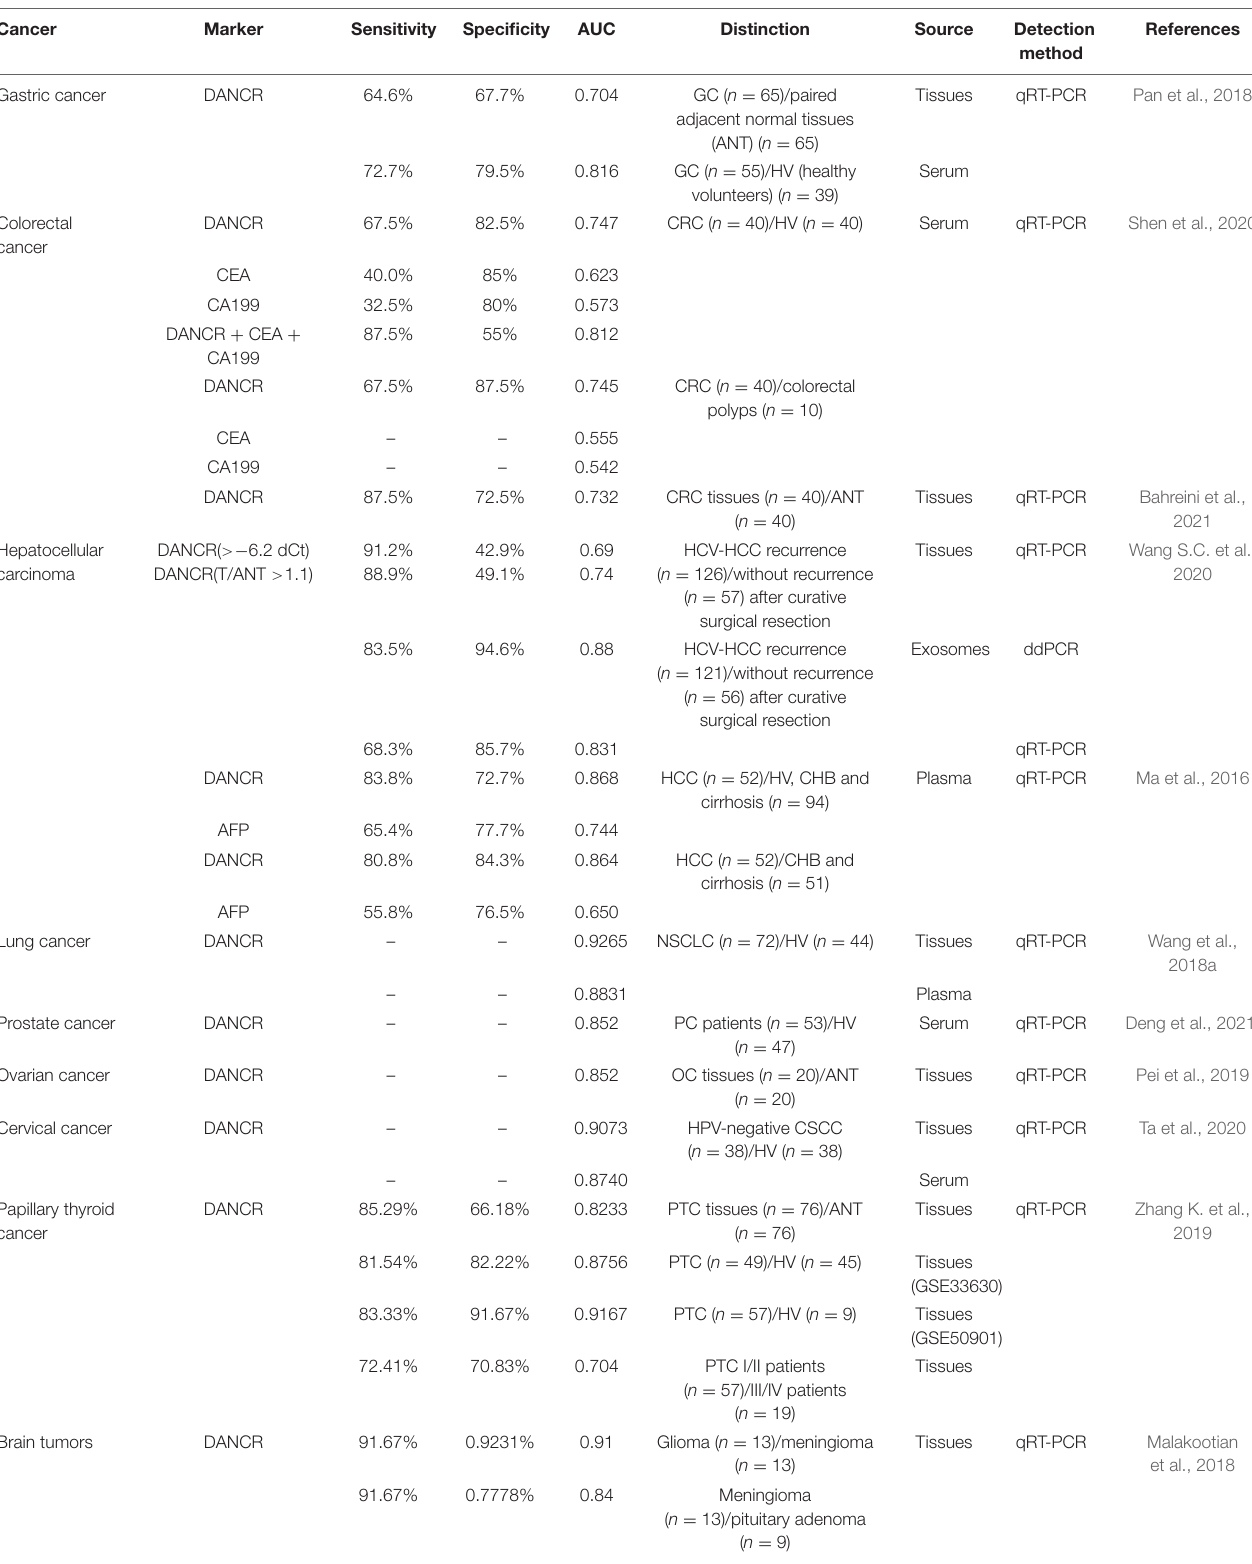
TABLE 2 | The diagnostic and prognostic value of DANCR in